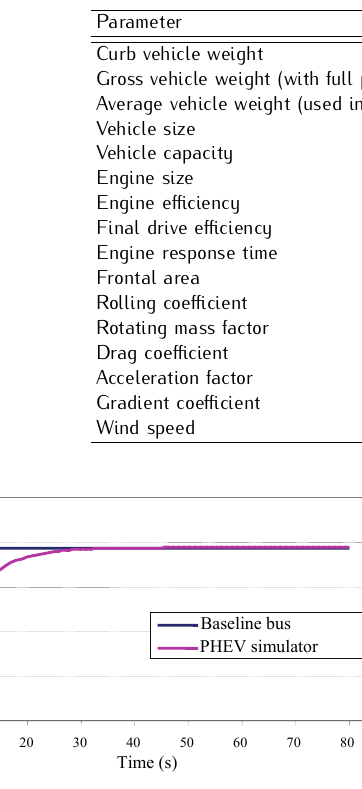
Table 2. Baseline transit bus model specifications.